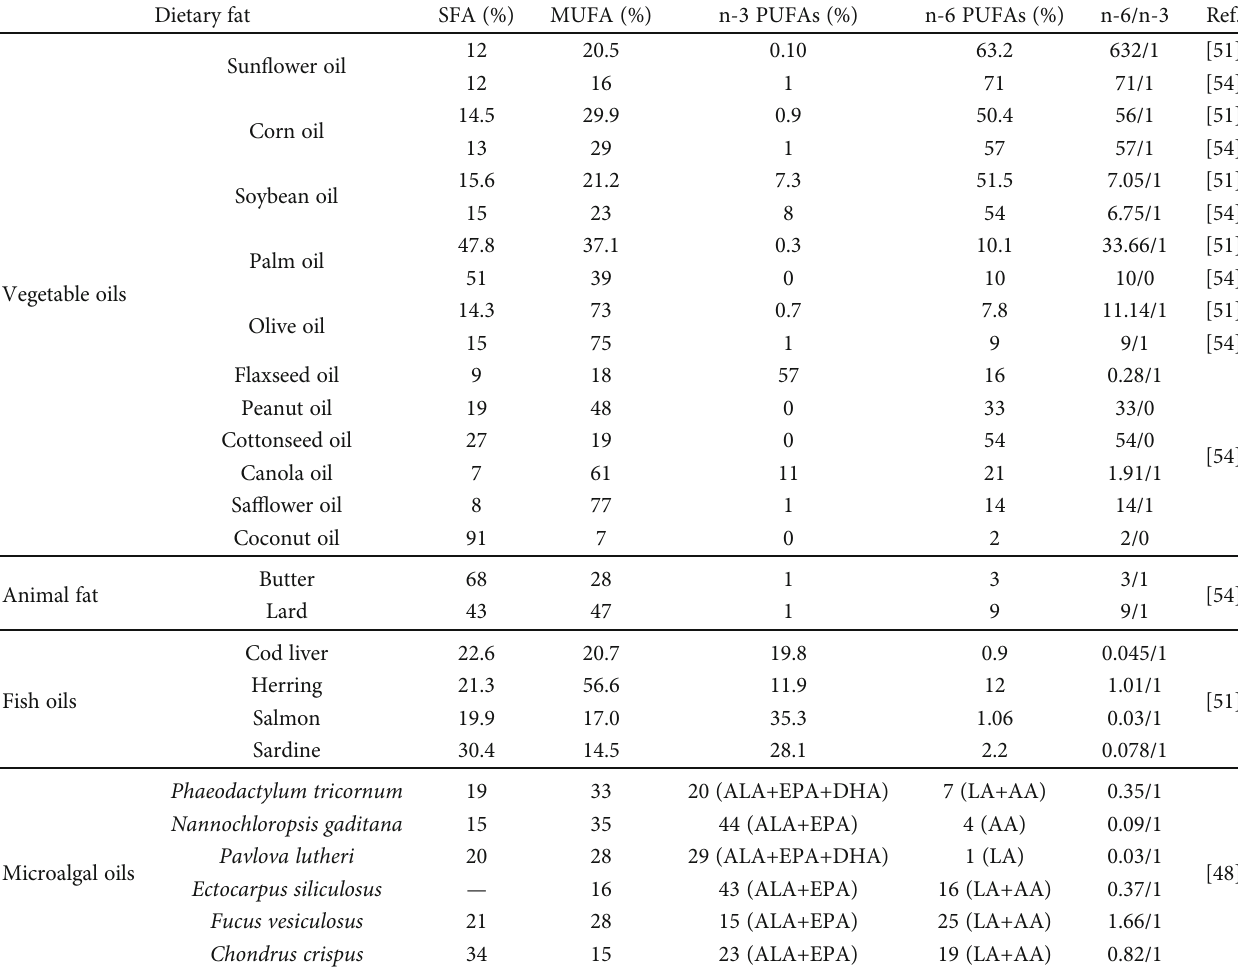
Table 3: Fatty acid composition (%) and n-6/n-3 ratio of di ff erent vegetable oils, animal fat, fi sh oils, and microalgal oils. Dietary